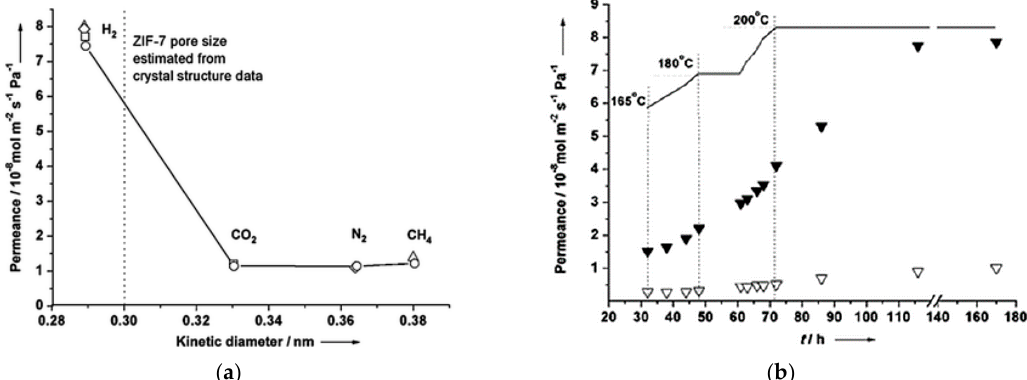
Figure 22. ( a ) H 2 (solid triangles) and N 2 (triangles) permeance from the mixture through the ZIF-7 membrane during the on-stream activation process with increasing temperature. ( b ) permeance of single gases (circles) and from mixtures (squares: H 2 –CO 2 mixture, rhombuses: H 2 –N 2 mixture, triangles: H 2 –CH 4 mixture) of the ZIF-7 membrane at 200 °C as a function of molecular kinetic diameters (adapted with permission from ref. [123]).